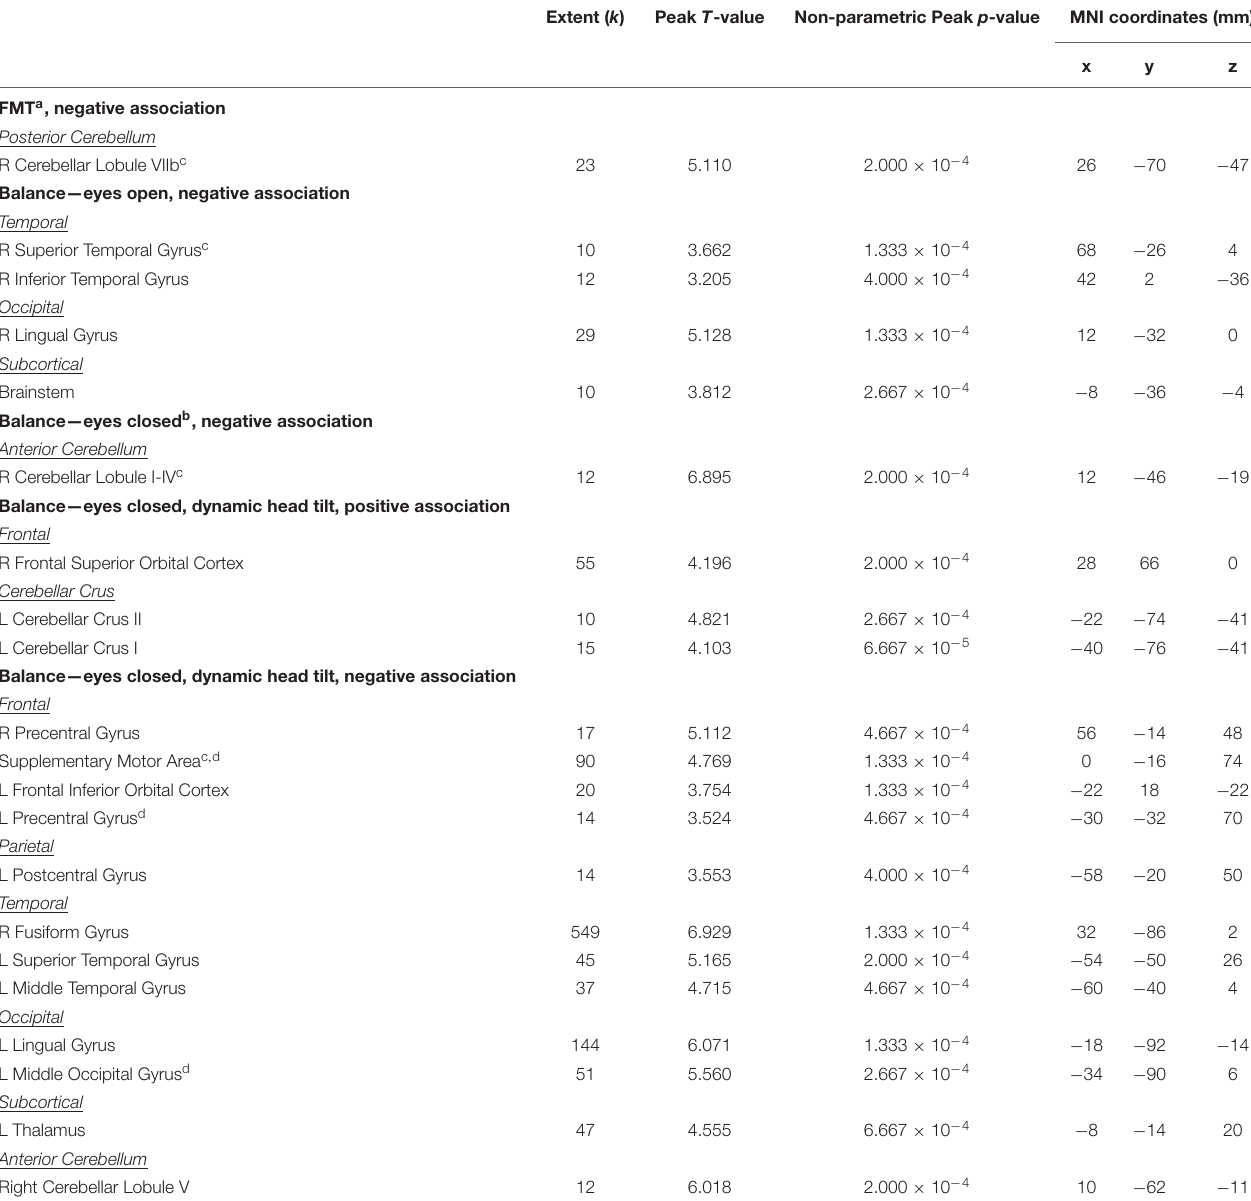
TABLE 4 | Regions showing associations between pre- to post-HDBR + CO 2 differences in behavioral scores and pre- to post-HDBR + CO 2 change in brain activation during vestibular stimulation. Extent ( k ) Peak T -value Non-parametric Peak p -value MNI coordinates